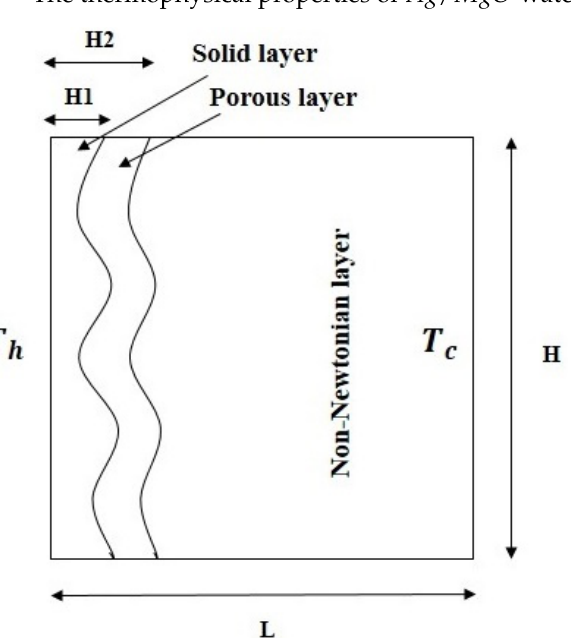
Figure 1. Computational sketch of the present